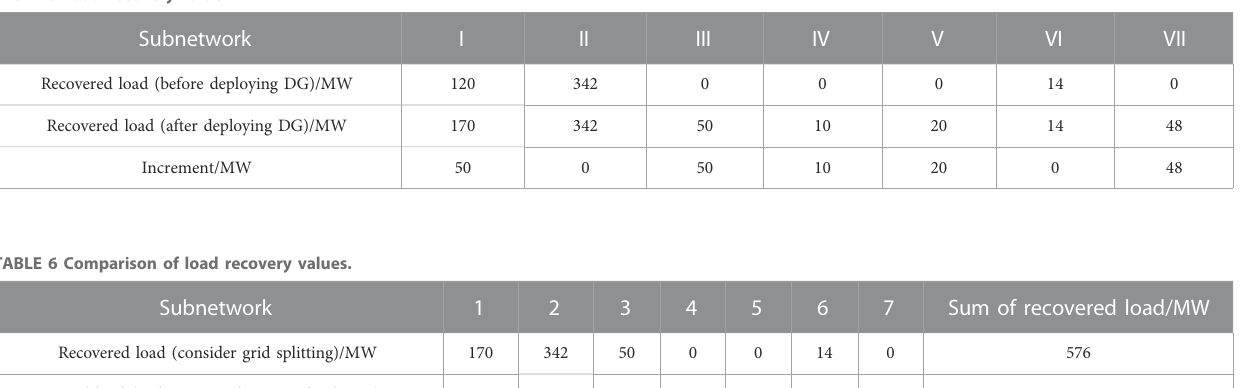
TABLE 5 Load recovery value.